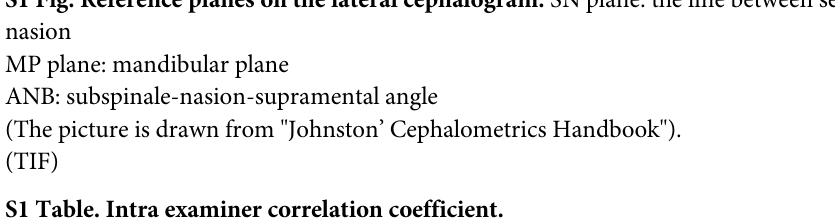
S1 Fig. Reference planes on the lateral cephalogram. SN plane: the line between sella and nasion MP plane: mandibular plane